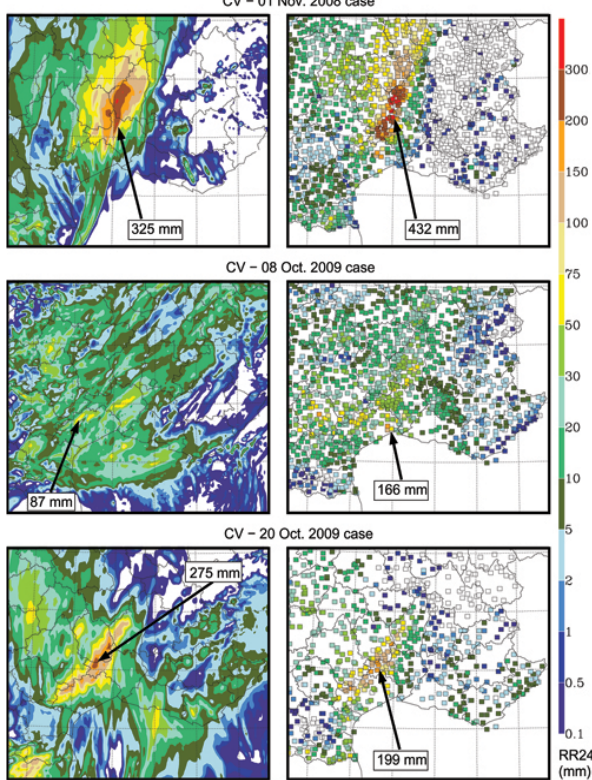
Fig. 4. Same as Fig. 3, but at 06:00UTC, 2 November 2008 for the 1 November 2008 case (top), at 06:00UTC, 9 October 2009 for the 8 October 2009 case (middle) and at 12:00UTC, 21 October 2009 for the 20 October 2009 case